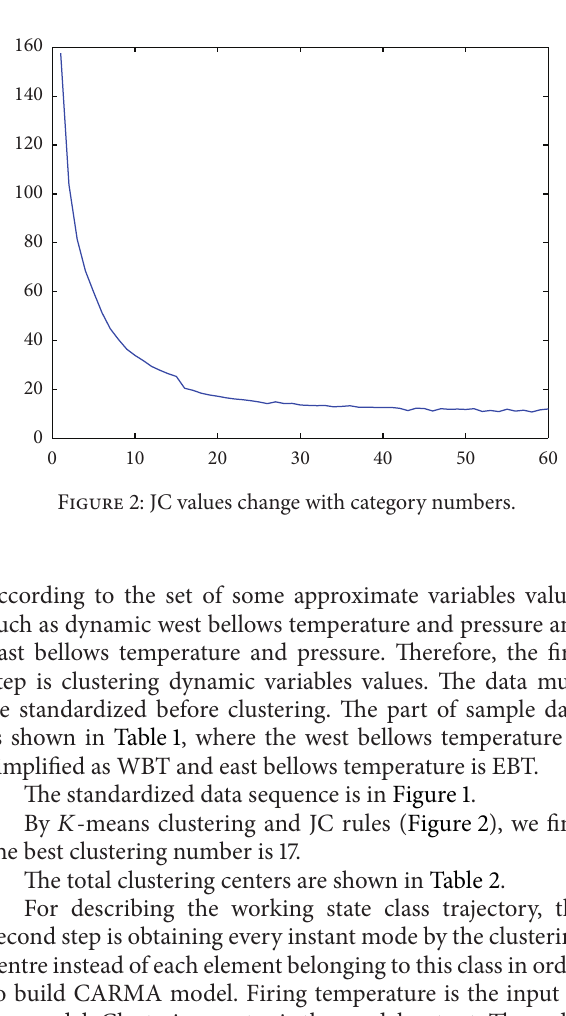
Figure 1: Working state time series in feature space.